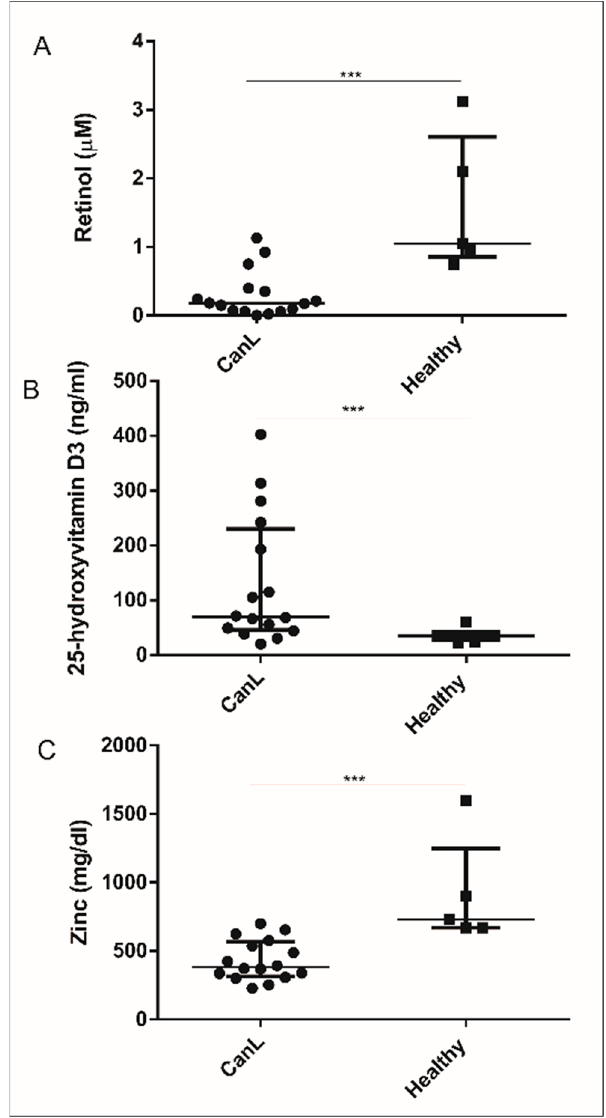
Figure 1. Serum levels of nutrients in the CanL group and in healthy dogs. Low levels of retinol ( A ) and Zn ( C ) and higher levels of 25(OH)VD 3 ( B ) were observed in the CanL group ( n = 15) compared to healthy dogs ( n = 5). Data represent the median and interquartile range (IQR). Asterisks indicate a significant difference between the CanL group and healthy dogs (Mann–Whitney test, *** p < 0.001).